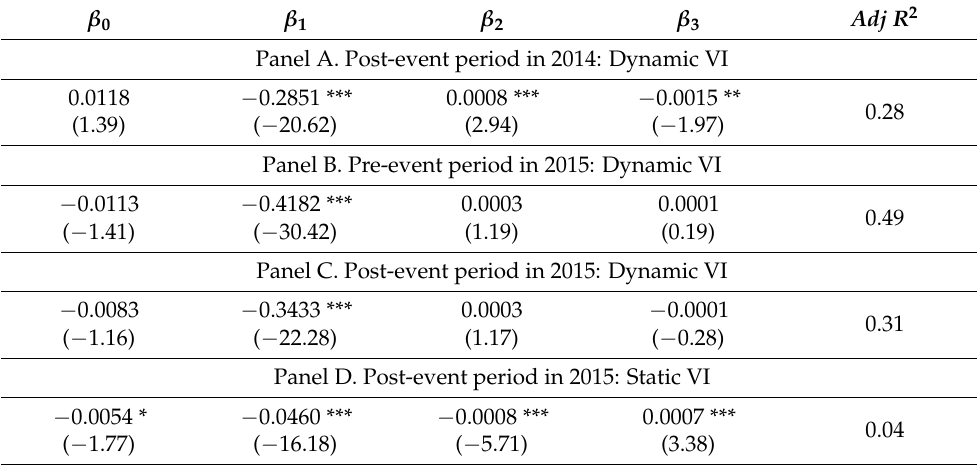
Table 4. Panel-data analysis as a robustness check. This table provides the results of the following standard panel-data analysis, with the analyses for dynamic and static VIs performed separately over the respective subperiods. *, **, and *** denote the 10%, 5%, and 1% statistical